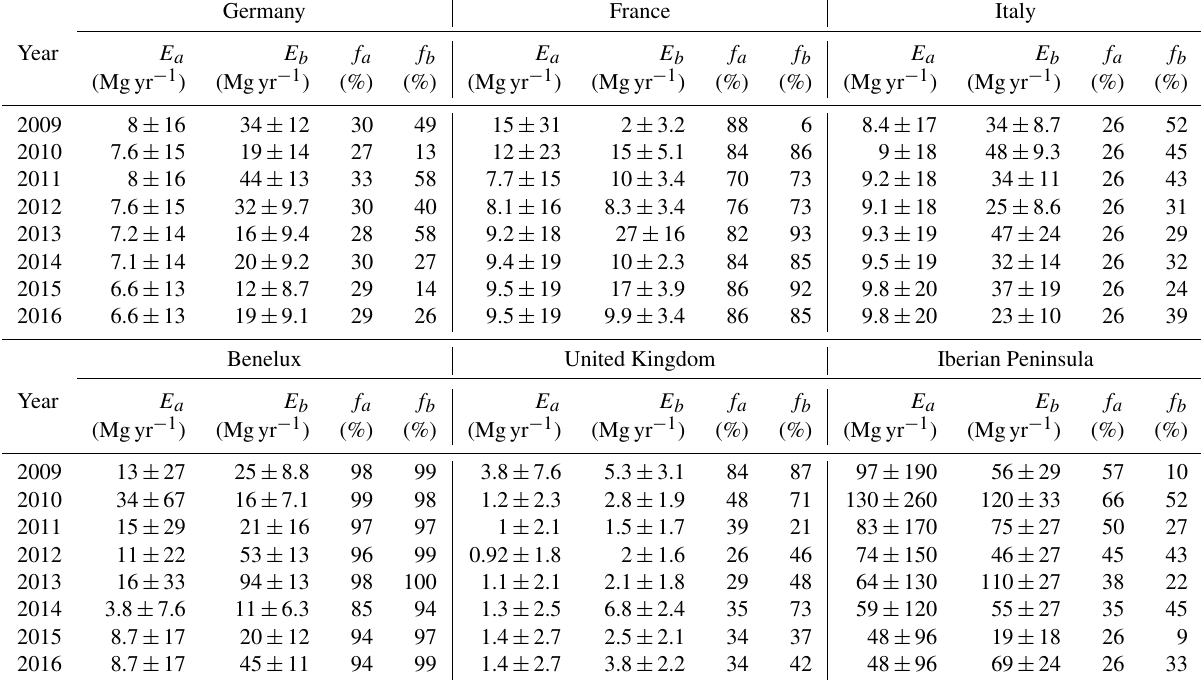
Table 4. European HFC-23 emissions (tonne, Mg) by country/region: E a a priori, E b a posteriori emissions, f a fraction of a priori emissions from factory locations, f b fraction of a posteriori emissions from factory locations. All values represent averages from both inversions using different a priori distributions.